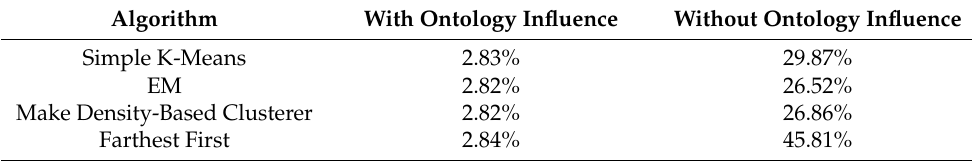
Table 5. Percentage of Incorrectly Clustered Instances on Amazon Product Reviews Dataset.